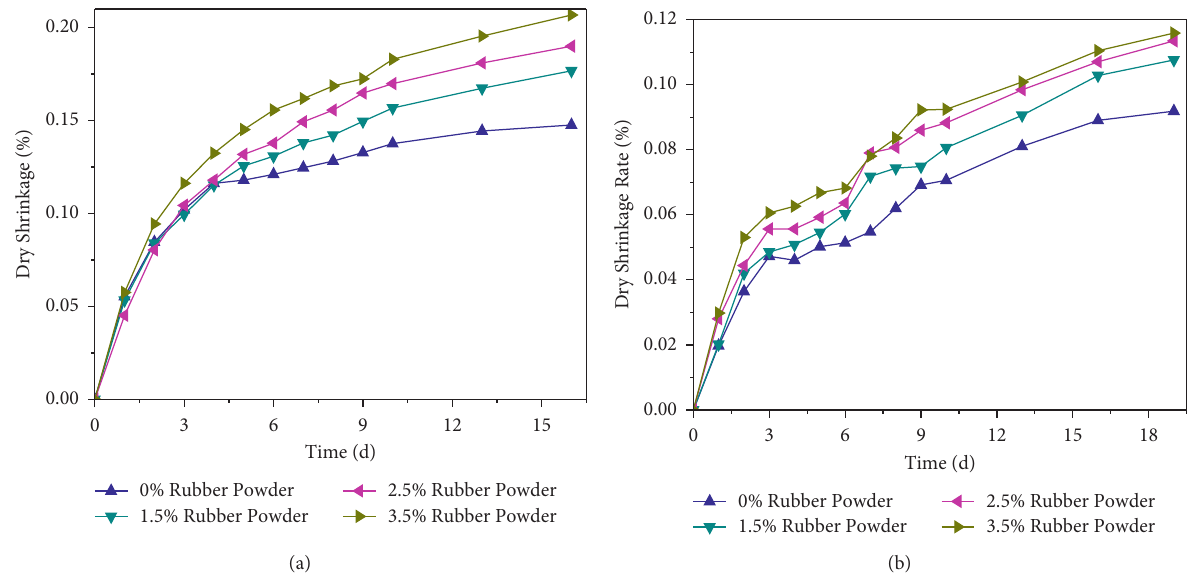
Figure 9: Drying shrinkage rates of mortar with different rubber powder contents under (a) RH � 40% and (b) RH � 70%.